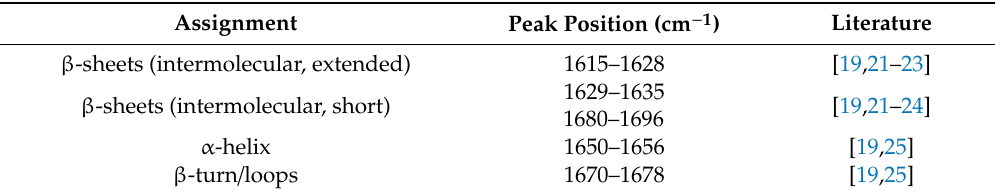
Table 2. Proteins: assignment of amide I band positions to secondary structure.